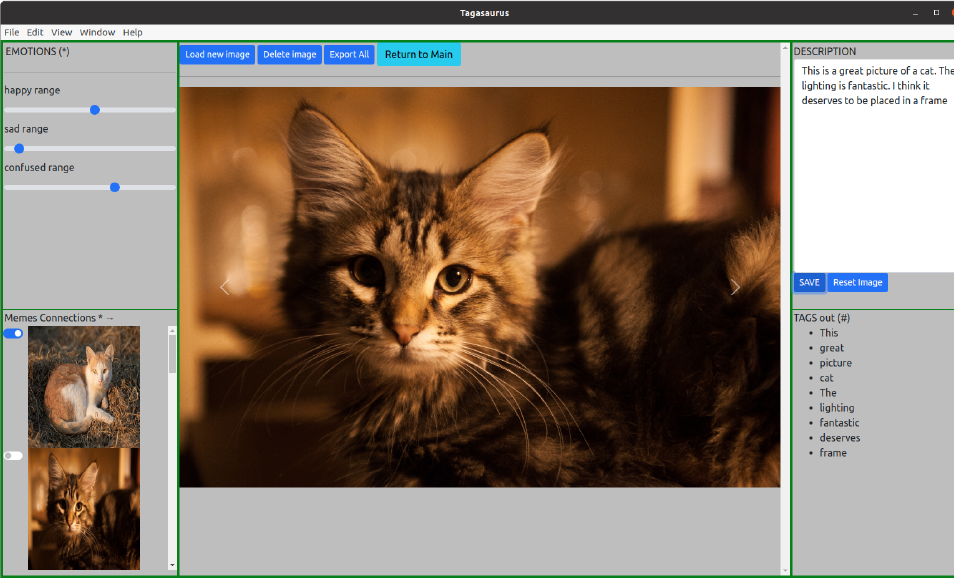
Figure 3. Interface screenshot with what the user can see when using Tagasaurus to annotate photos. The center image is displayed in a carousel gallery so that a user can slide through the set of images and sequentially provide annotations. Image used: [Tadeáš Bednarz (2019), ‘A tabby cat’, Wikimedia Commons, https://en.wikipedia.org/wiki/Cat#/media/File:Siberian_black_tabby_blotched_cat_ 03.jpg (accessed on 31 May